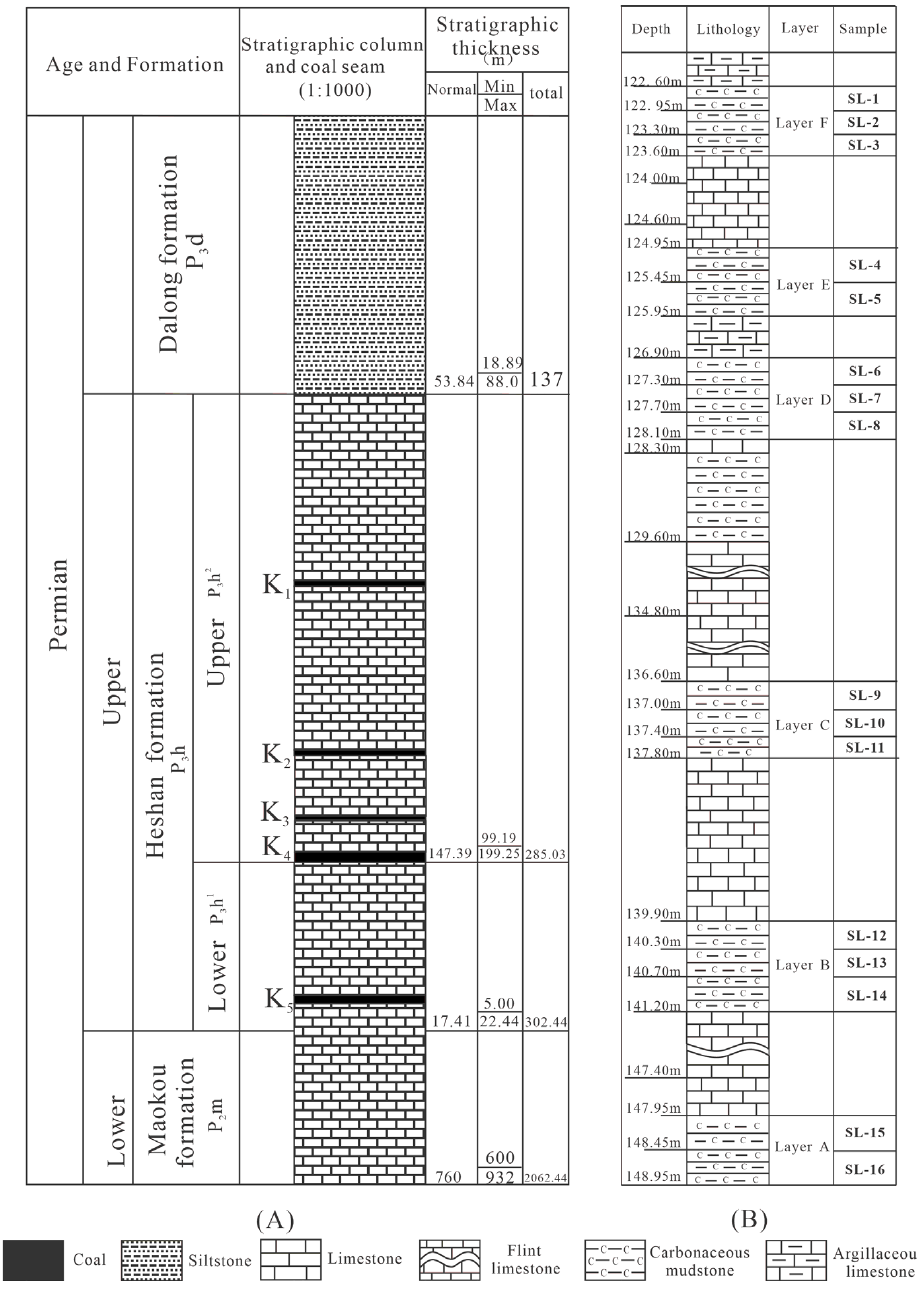
Figure 2. ( A ) The generalized stratigraphic column of the late Permian coal-bearing strata within the Xian’an Coalfield [6]; ( B ) sampling column of borehole SL.